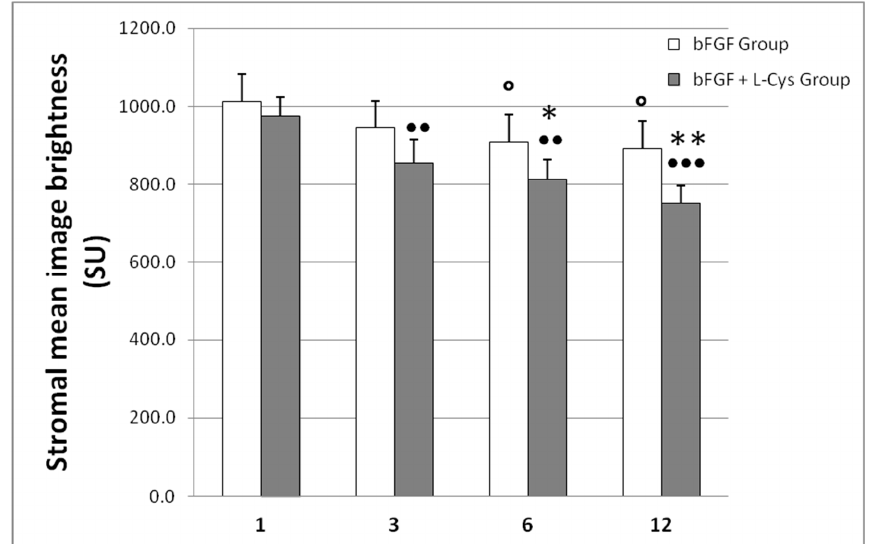
Figure 2. Mean image brightness of the stroma (marker of altered cornea), measured with the ConfoScan 4 confocal microscope and expressed as mean ± SD scatter units (SU) in corneas of patients who received only bFGF (bFGF Group) and of patients who were administered topical bFGF plus oral L -cysteine supplementation (bFGF + L -cys Group). ° p < 0.05 bFGF Group at 3, 6, and 12 months of follow-up vs. bFGF at 1 month of follow-up; ●● p < 0.01 and ●●● p < 0.001 bFGF + L -cys Group at 3, 6, and 12 month of follow-up vs. bFGF + L -cys Group at 1 month of follow-up; * p < 0.03 and ** p < 0.001 (cid:35) bFGF + L -cys Group vs. bFGF Group at each time of follow-up.